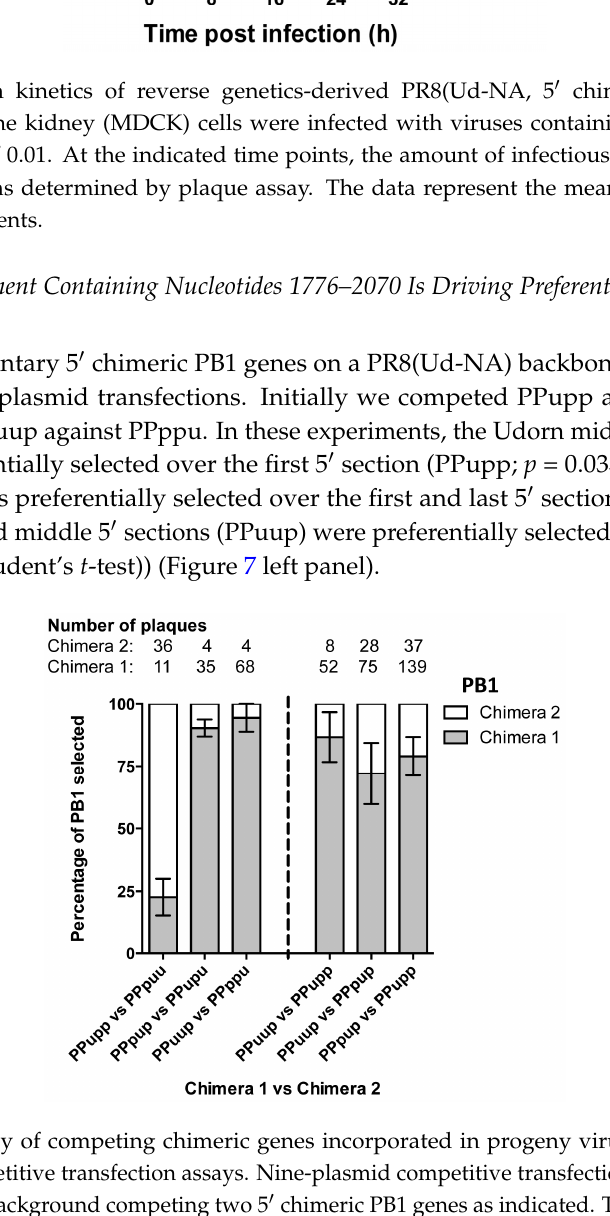
Figure 7. Frequency of competing chimeric genes incorporated in progeny viruses resulting from nine-plasmid competitive transfection assays. Nine-plasmid competitive transfections were performed on a PR8(Ud-NA) background competing two 5 (cid:48) chimeric PB1 genes as indicated. The origin of the PB1 gene segment from a random selection of progeny plaques was determined by gene-specific RT-PCR. the mean and standard errors of 2–5 individual